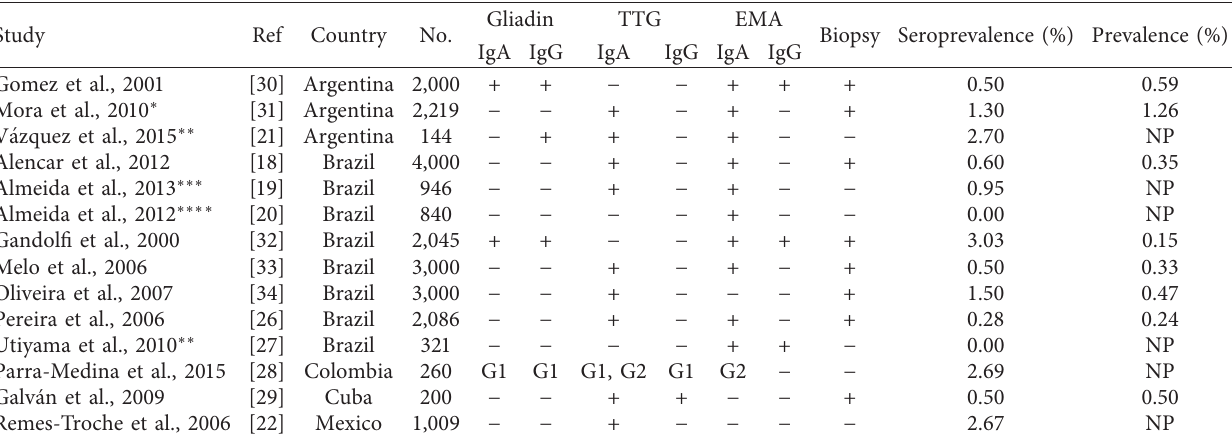
Figure 2: Percentages of ancestries in donors with seroreactive assays. African, European, and Native American membership percentages in samples from donors with seroreactive antibody assays. Table 2: Celiac disease prevalence studies performed in Latin America.